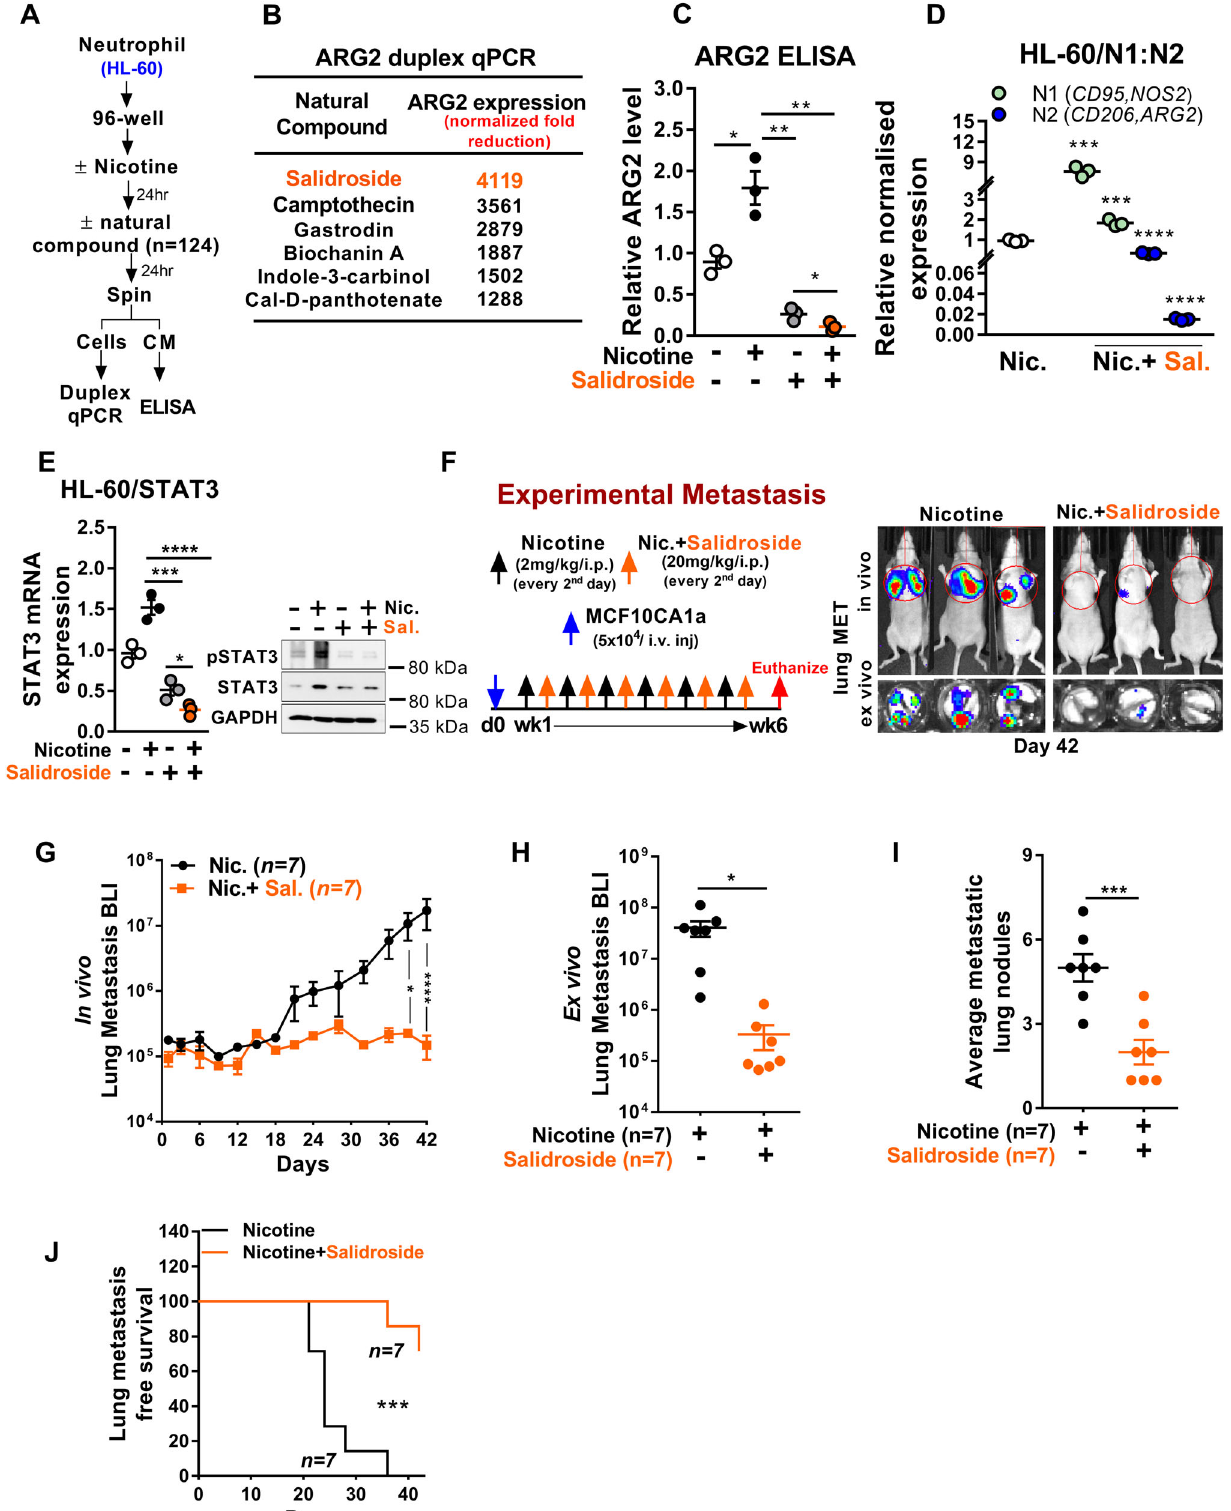
premetastatic lung 136 thereby highlighting the importance of environmental stimulations in establishing lung metastasis. Col- lectively, our fi ndings suggest spatiotemporal regulation of cancer cell plasticity by nicotine-activated N2-neutrophils that switches mesenchymal tumor cells into epithelial lineage to ef fi ciently grow at the